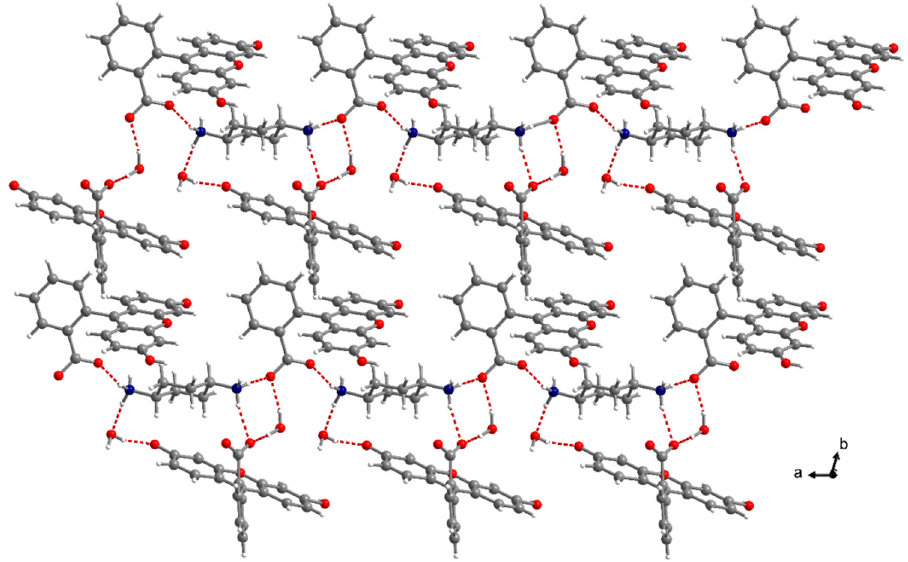
Figure 17. View along the crystallographic c axis of a packing diagram in crystal 9 .